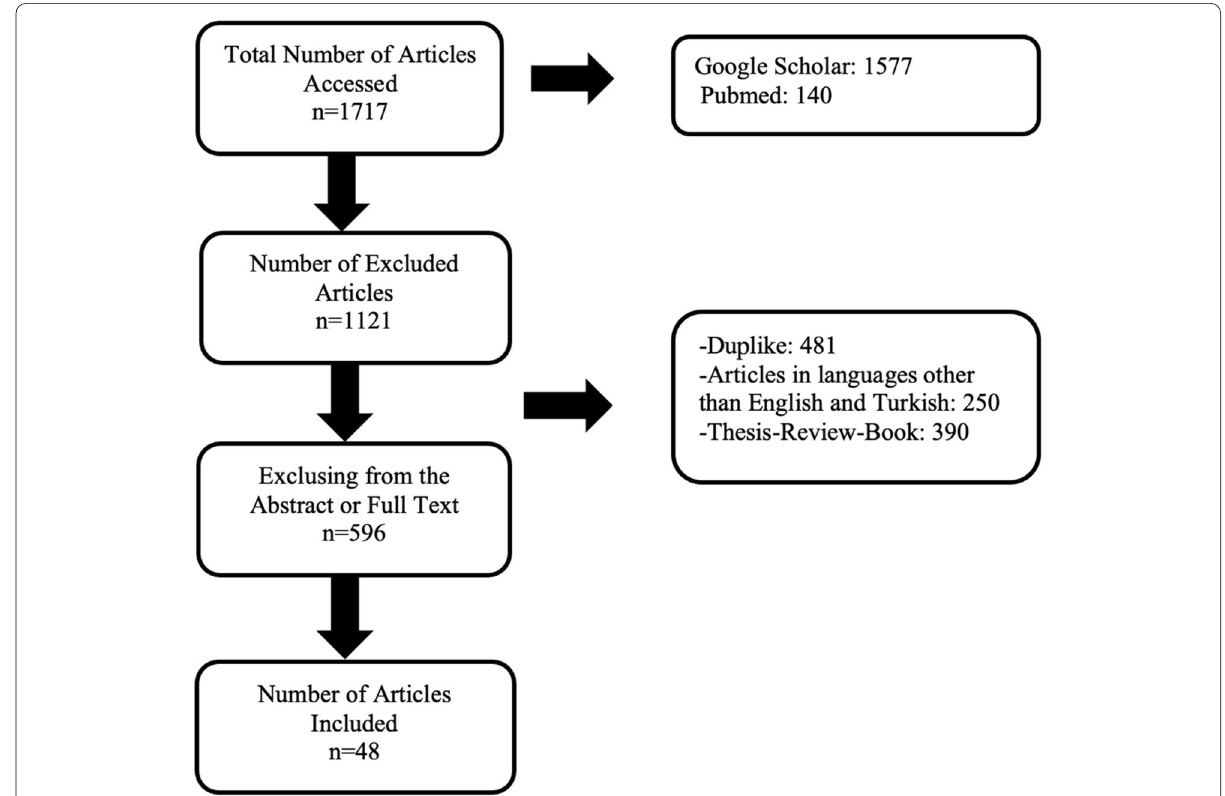
Fig. 1 Flowchart of articles through screening and selection